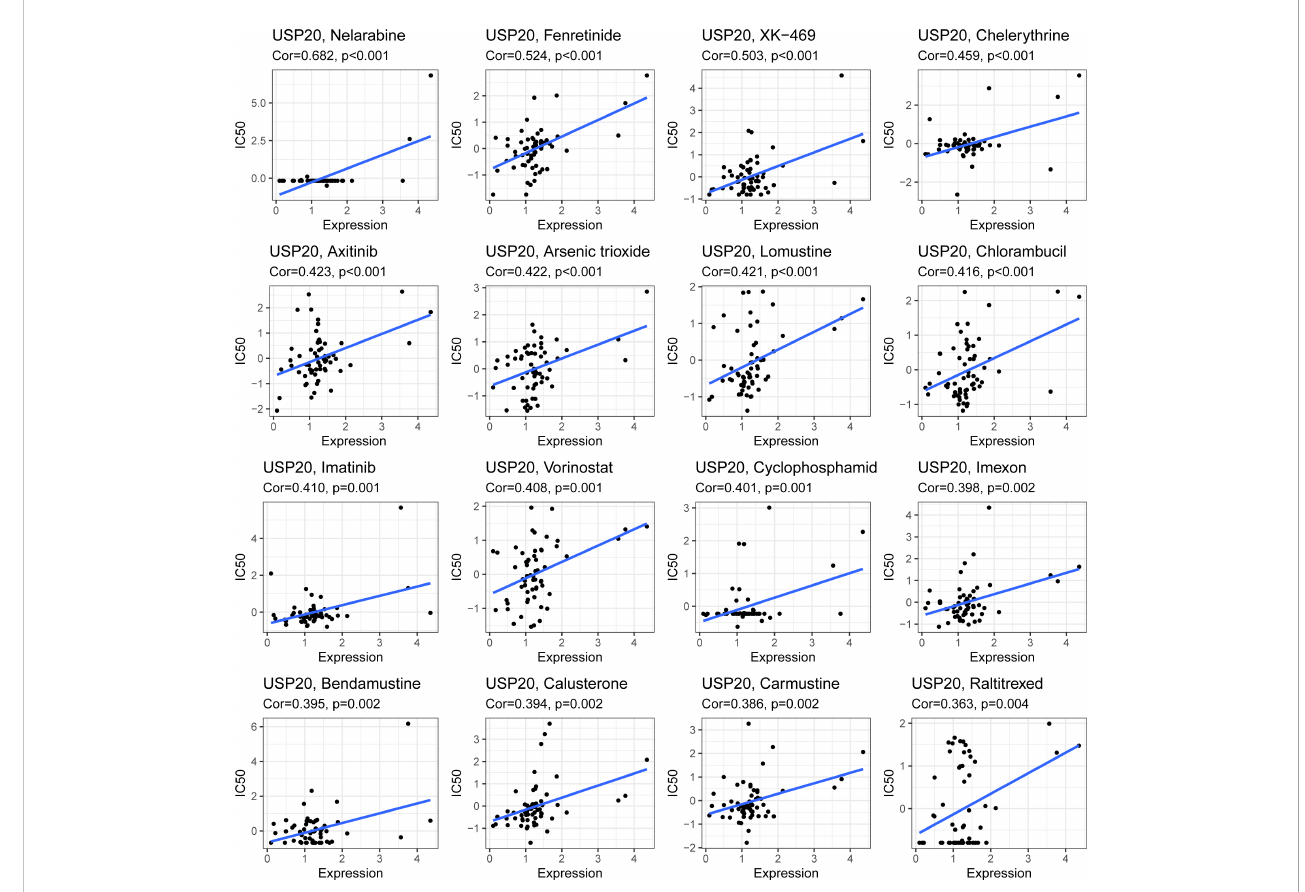
FIGURE 7 Scatter plots of the association between the USP20 expression and anti-tumor drugs